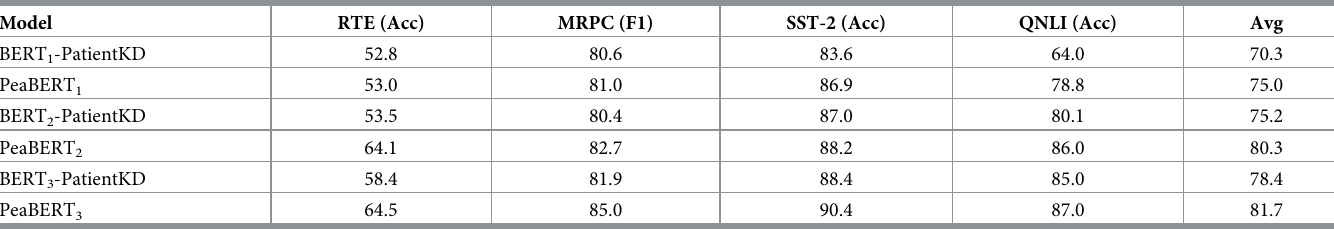
Table 2. Overall results of PeaBERT compared to the state-of-the-art KD baseline, PatientKD. Model